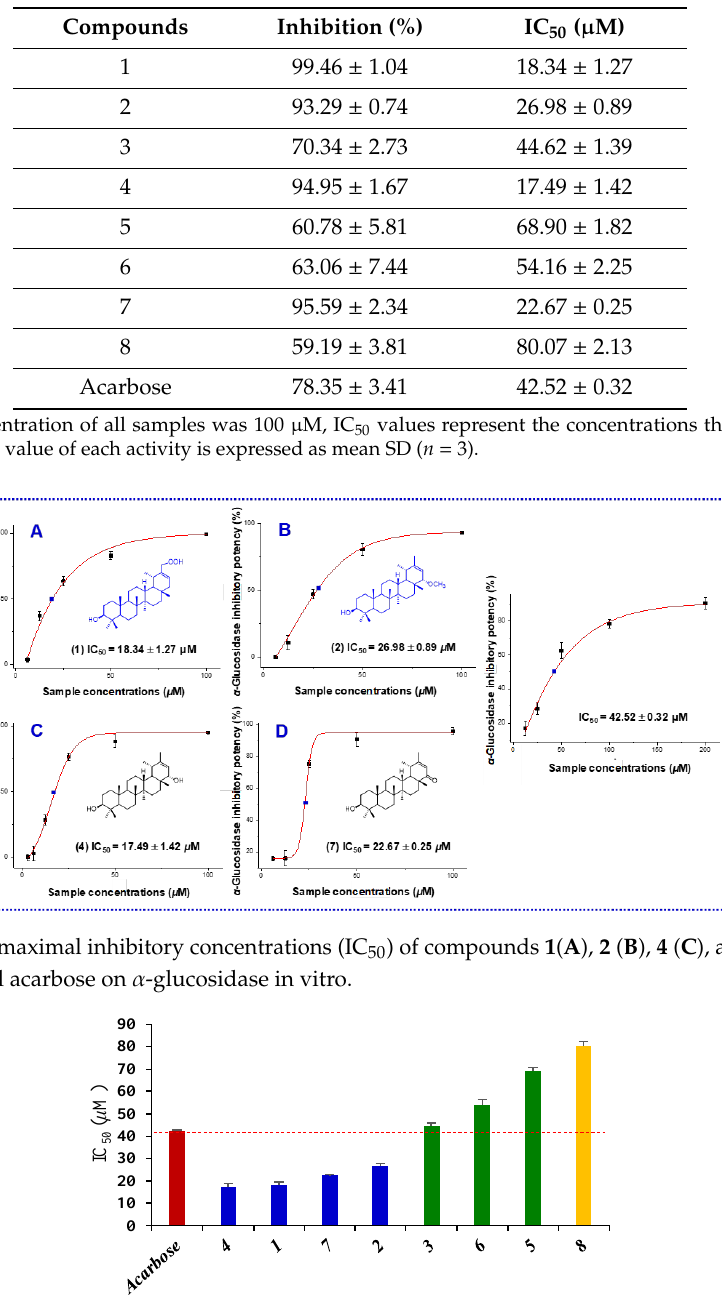
Table 2. α -Glucosidase inhibitory activities of isolates.